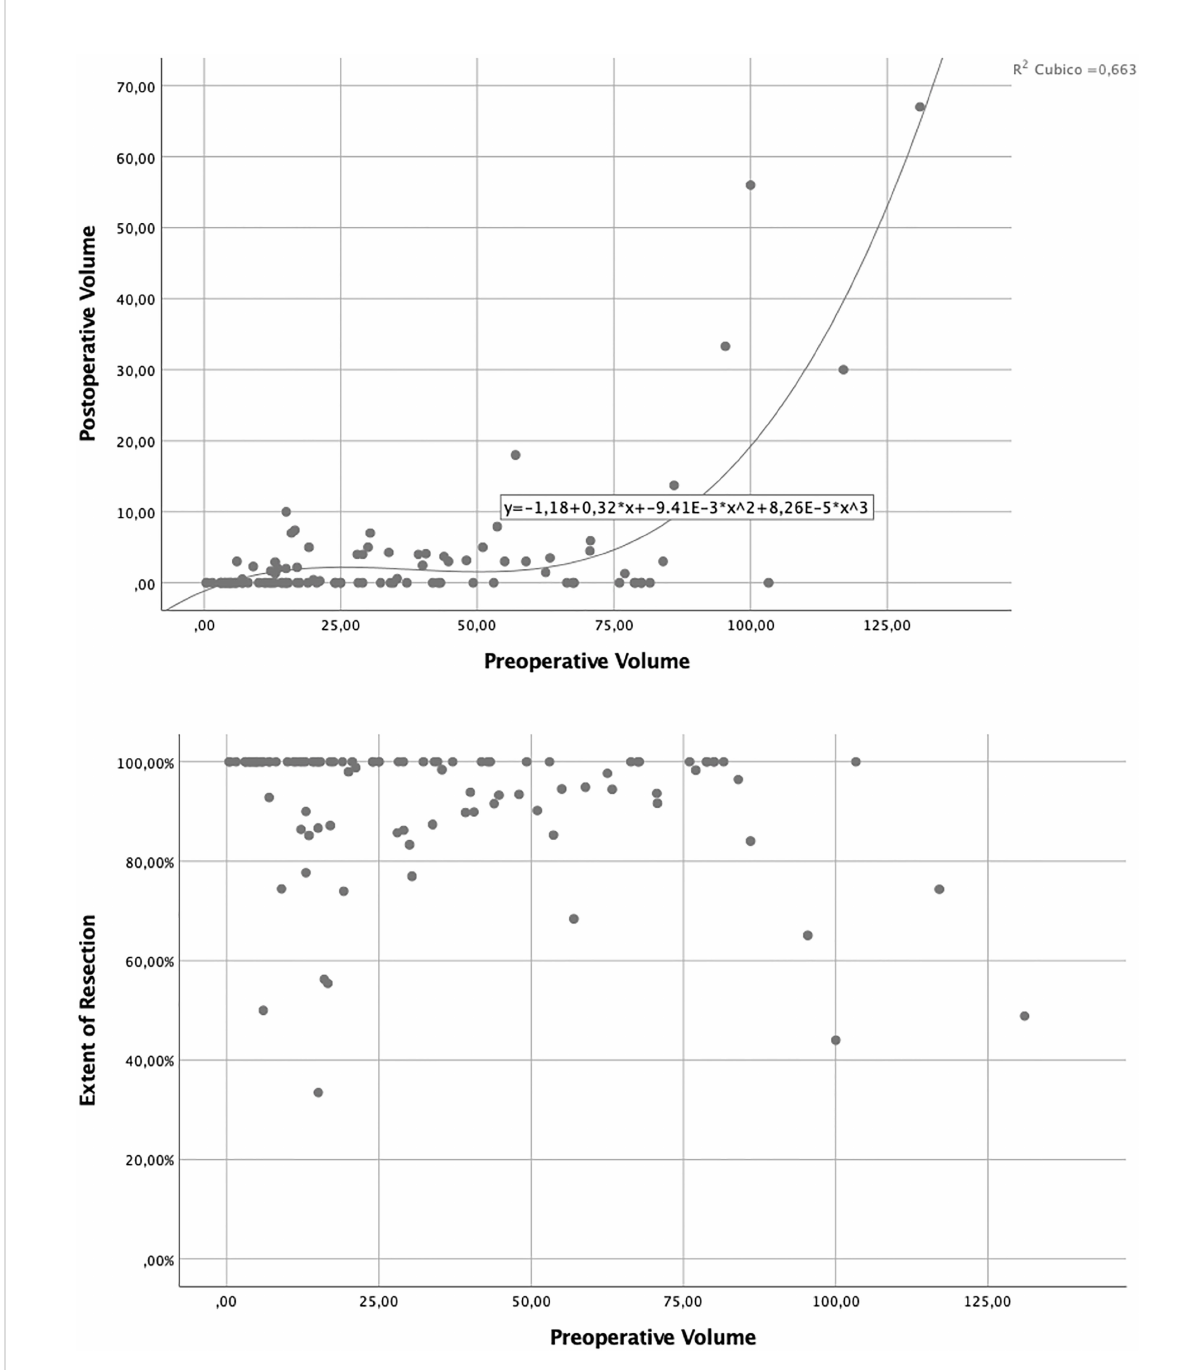
FIGURE 4 Volumetric analysis showing relations between preoperative tumor volume, residual tumor volume, and extent of